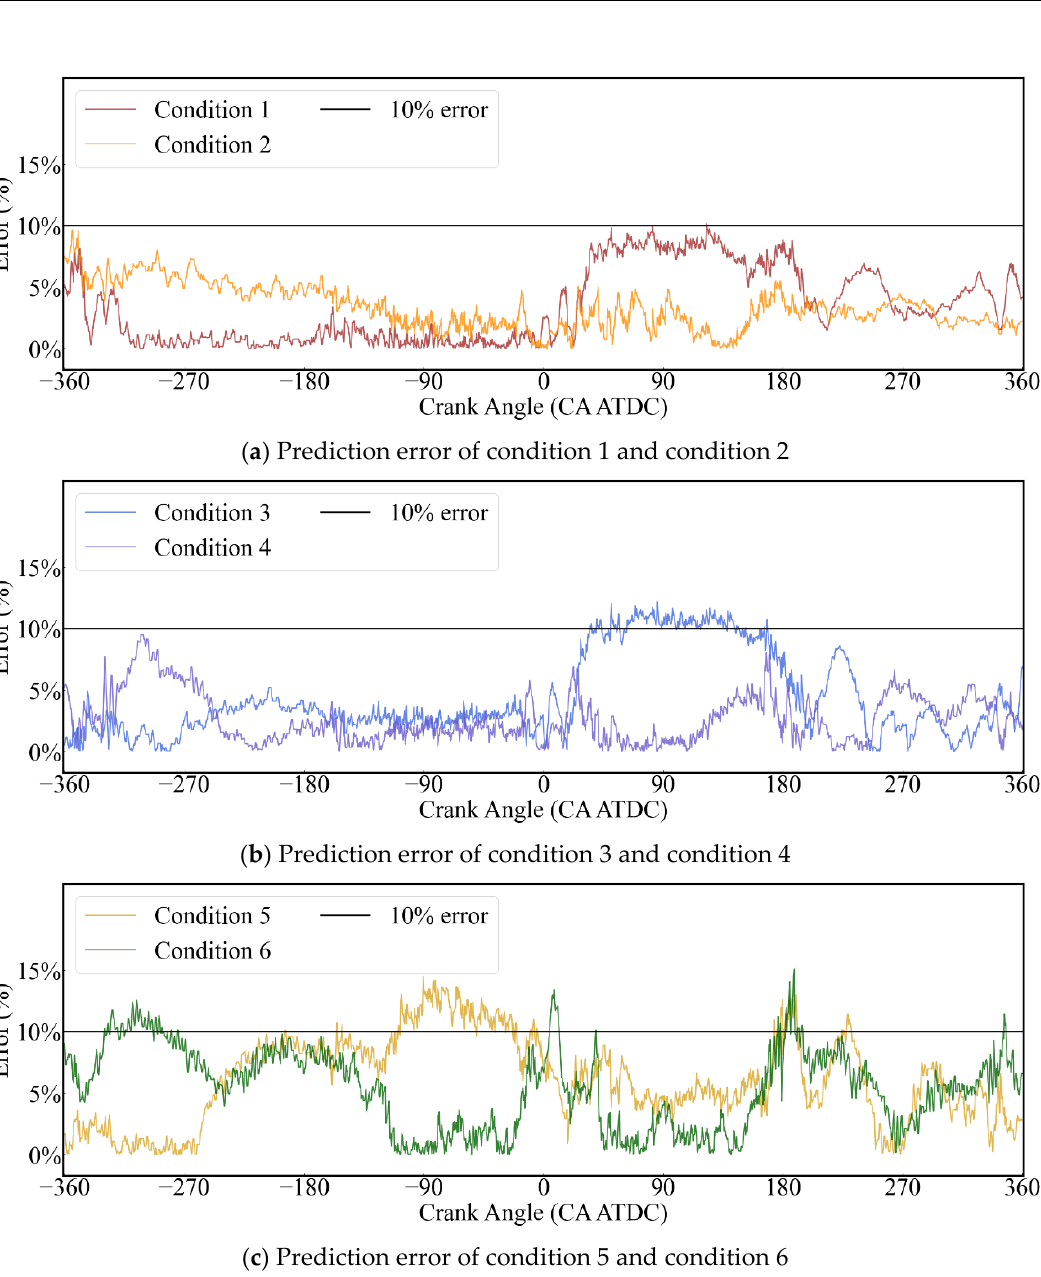
Figure 11. Error analysis of validation conditions.